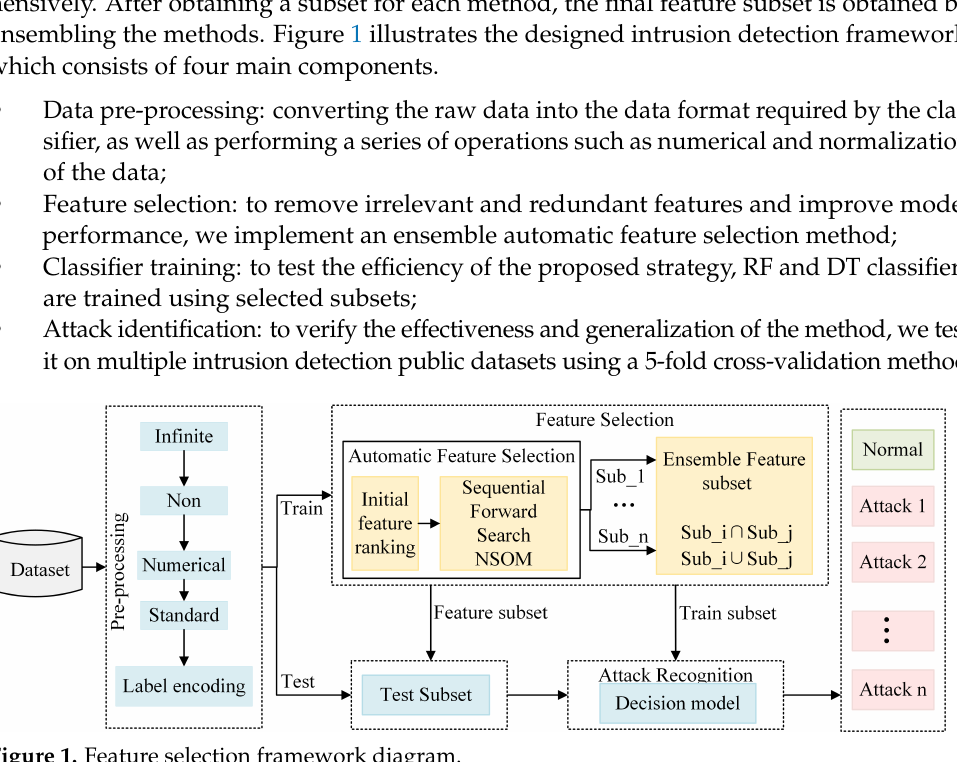
Figure 1. Feature selection framework